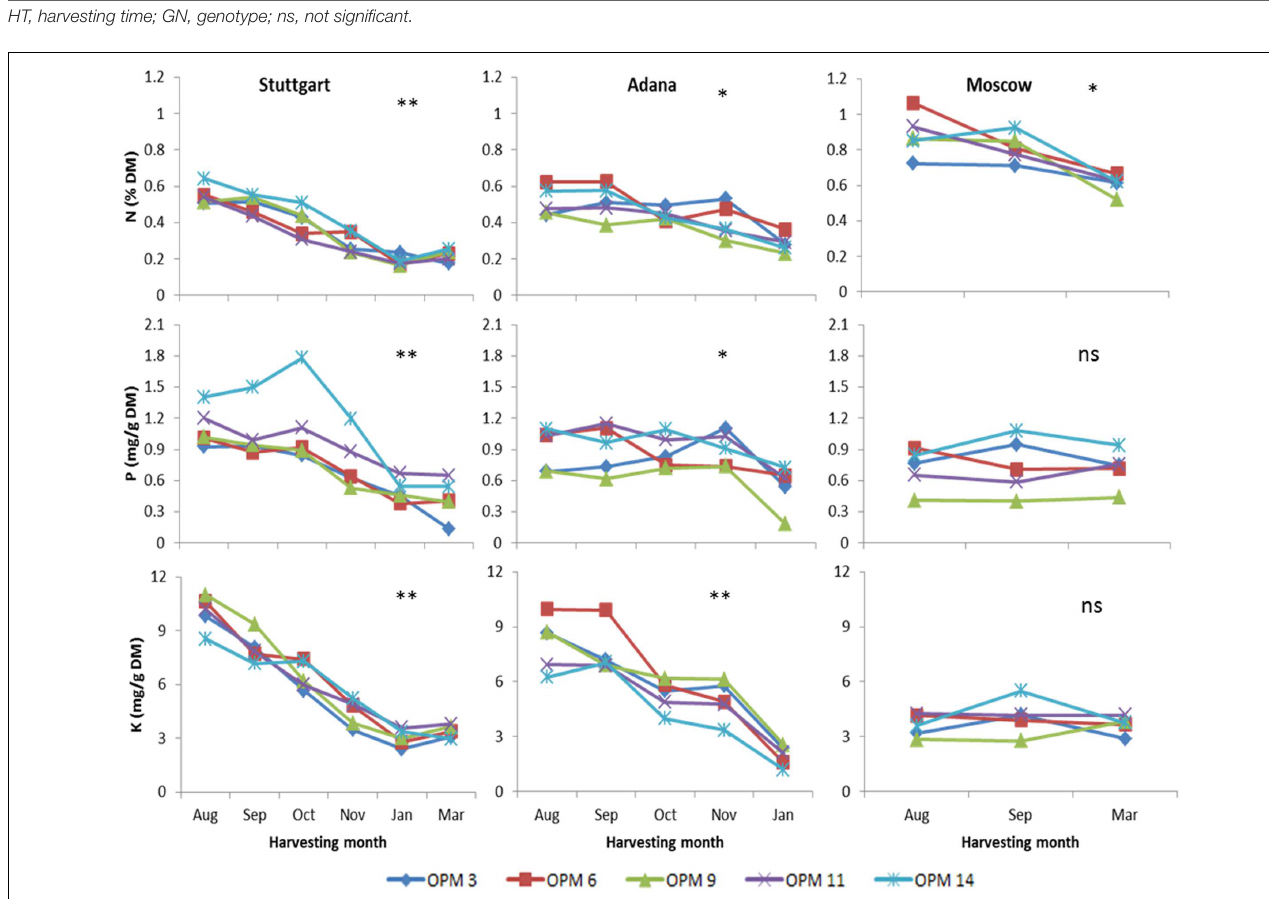
FIGURE 2 | Nitrogen, phosphorus, and potassium content of biomass from early to late harvest at Stuttgart, Adana, and Moscow for selected genotypes. Single asterisks ( ∗ ) indicate a significant impact ( P = 0.05) of interaction between harvesting time, genotype, and site. Double asterisks ( ∗∗ ) refer to a highly significant impact and “ns” indicates that the effect was not